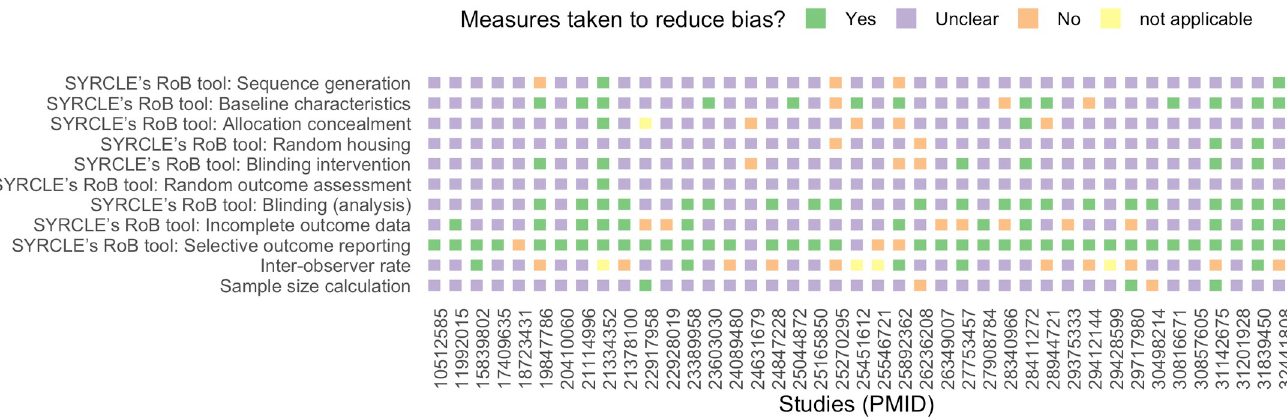
PLOS ONE | https://doi.org/10.1371/journal.pone.0249102 July 16,